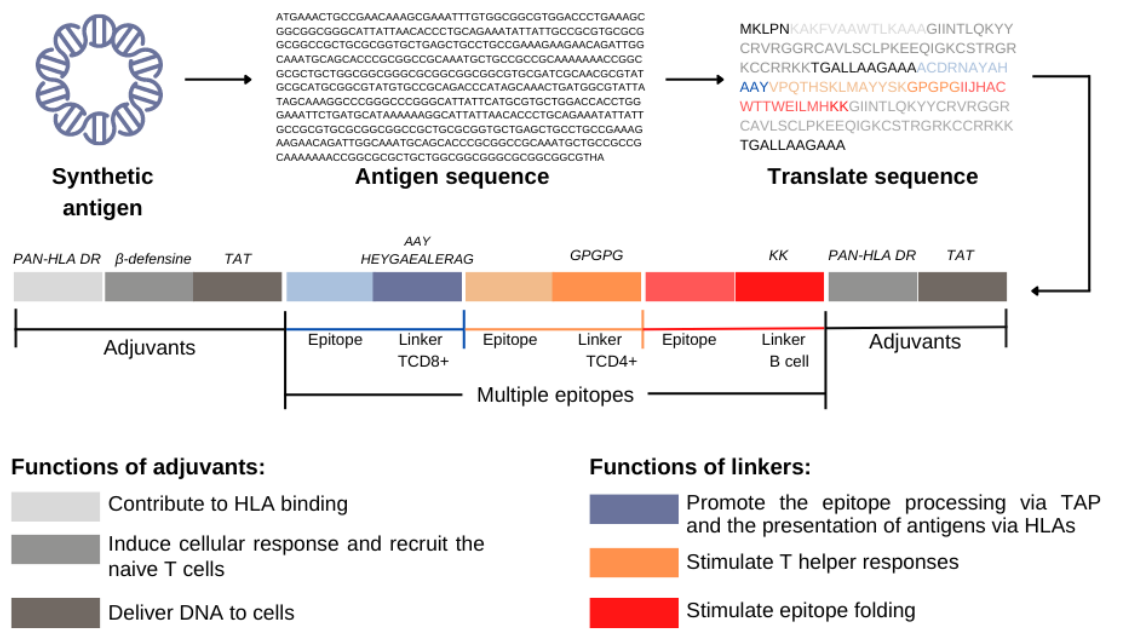
Figure 2. Functions of adjuvants and linkers in the synthetic antigen. They are sequences that help to cleave the peptide formed and stimulate the immune response, respectively.